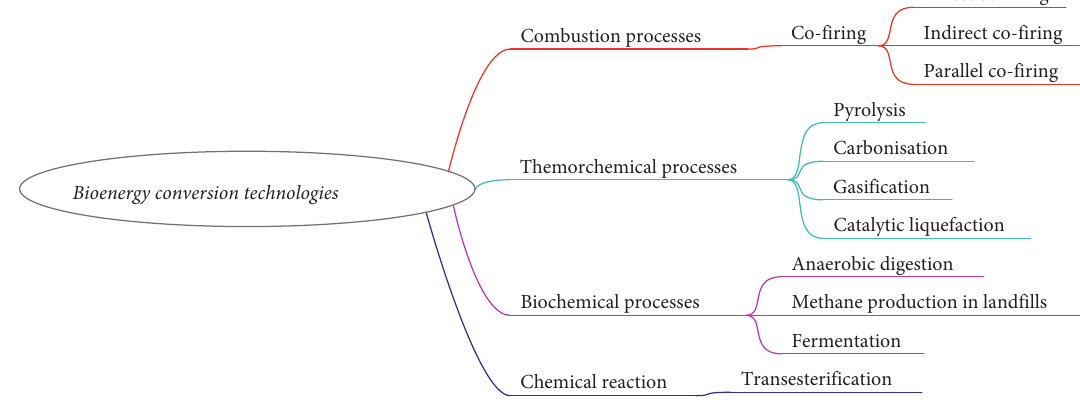
Figure 1: Biomass conversion processes [19, 20].